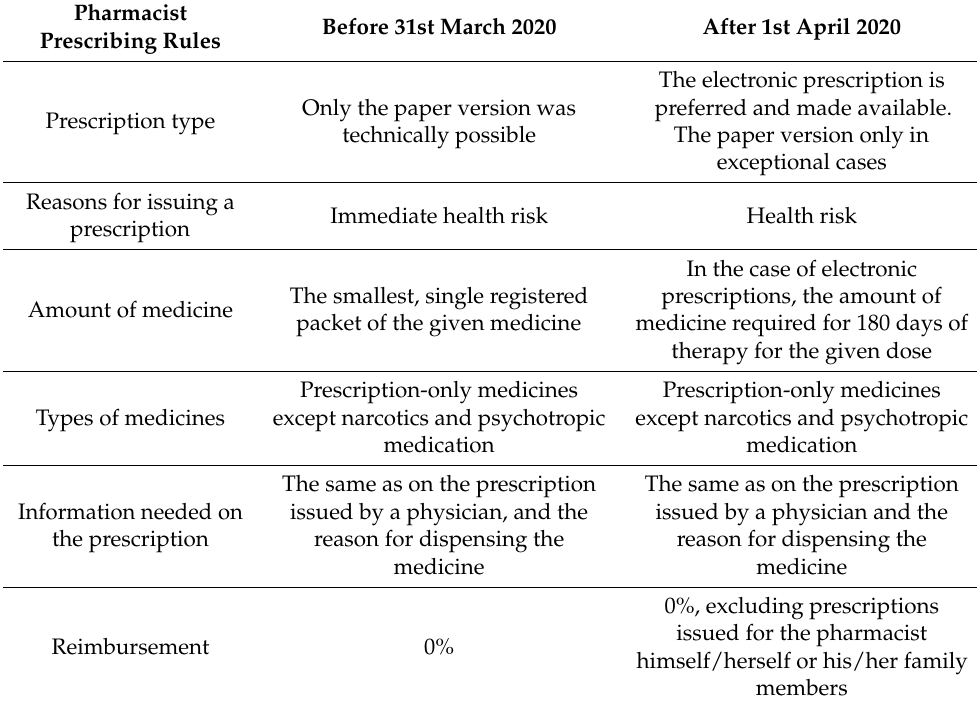
Table 1. Practice differences for issuing prescriptions in Poland before and after the COVID-19 epidemic was declared and law regulatory changes